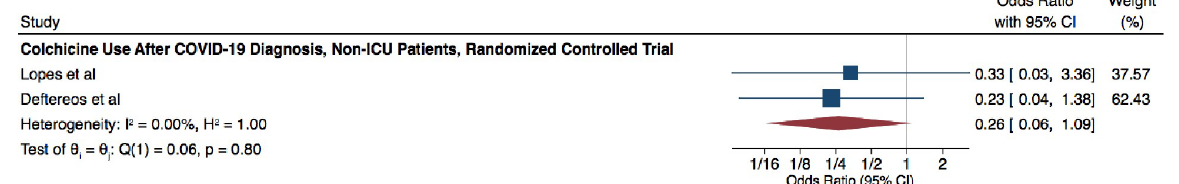
Fig 2. COVID-19 patients who used colchicine vs did not use colchicine–ICU admission analysis.